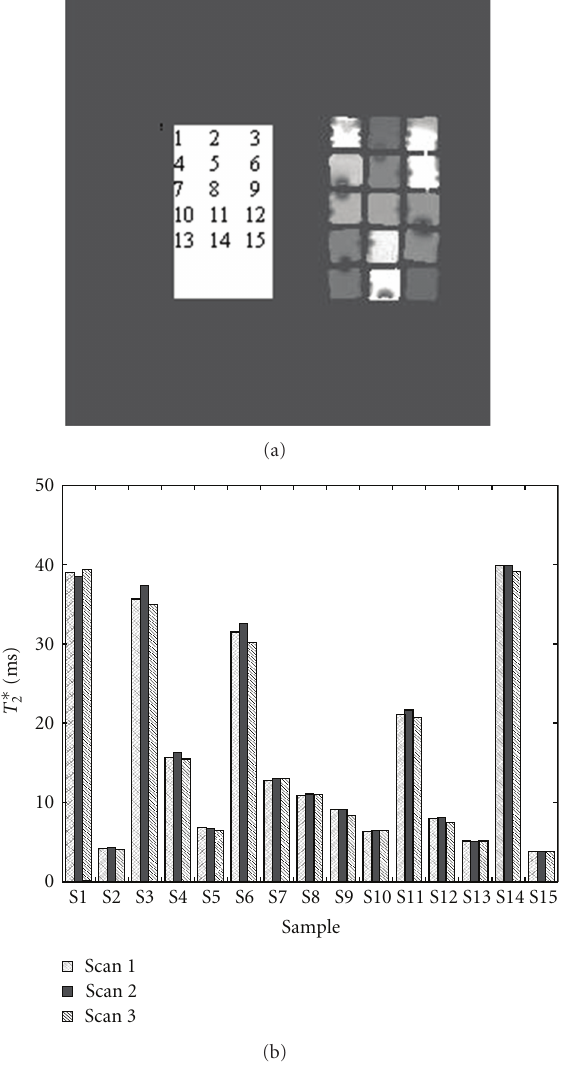
Figure 6: Results of phantom validation. (a) is the image of the FerriScan phantom consisting of fifteen di ff erent tubes with di ff erent solutions (di ff erent T ∗ 2 values). The sample numbers are defined on the left. (b) is the T ∗ 2 measurement from three scans in a year using the same clinical protocols. Consistent measurement was demonstrated in this